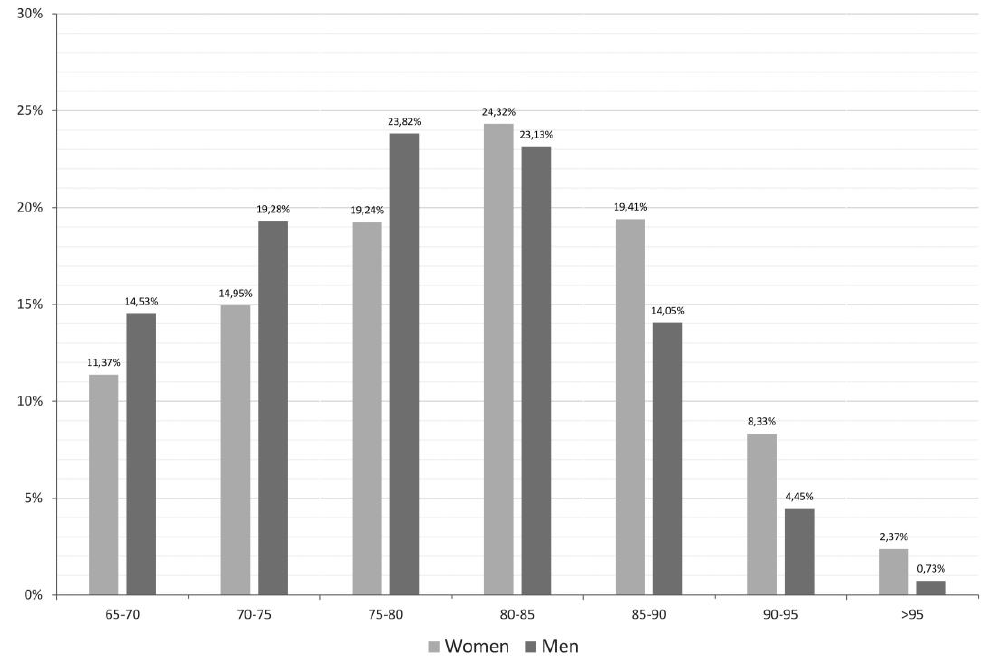
Figure 1. Frequency distribution according to sex and age classes.